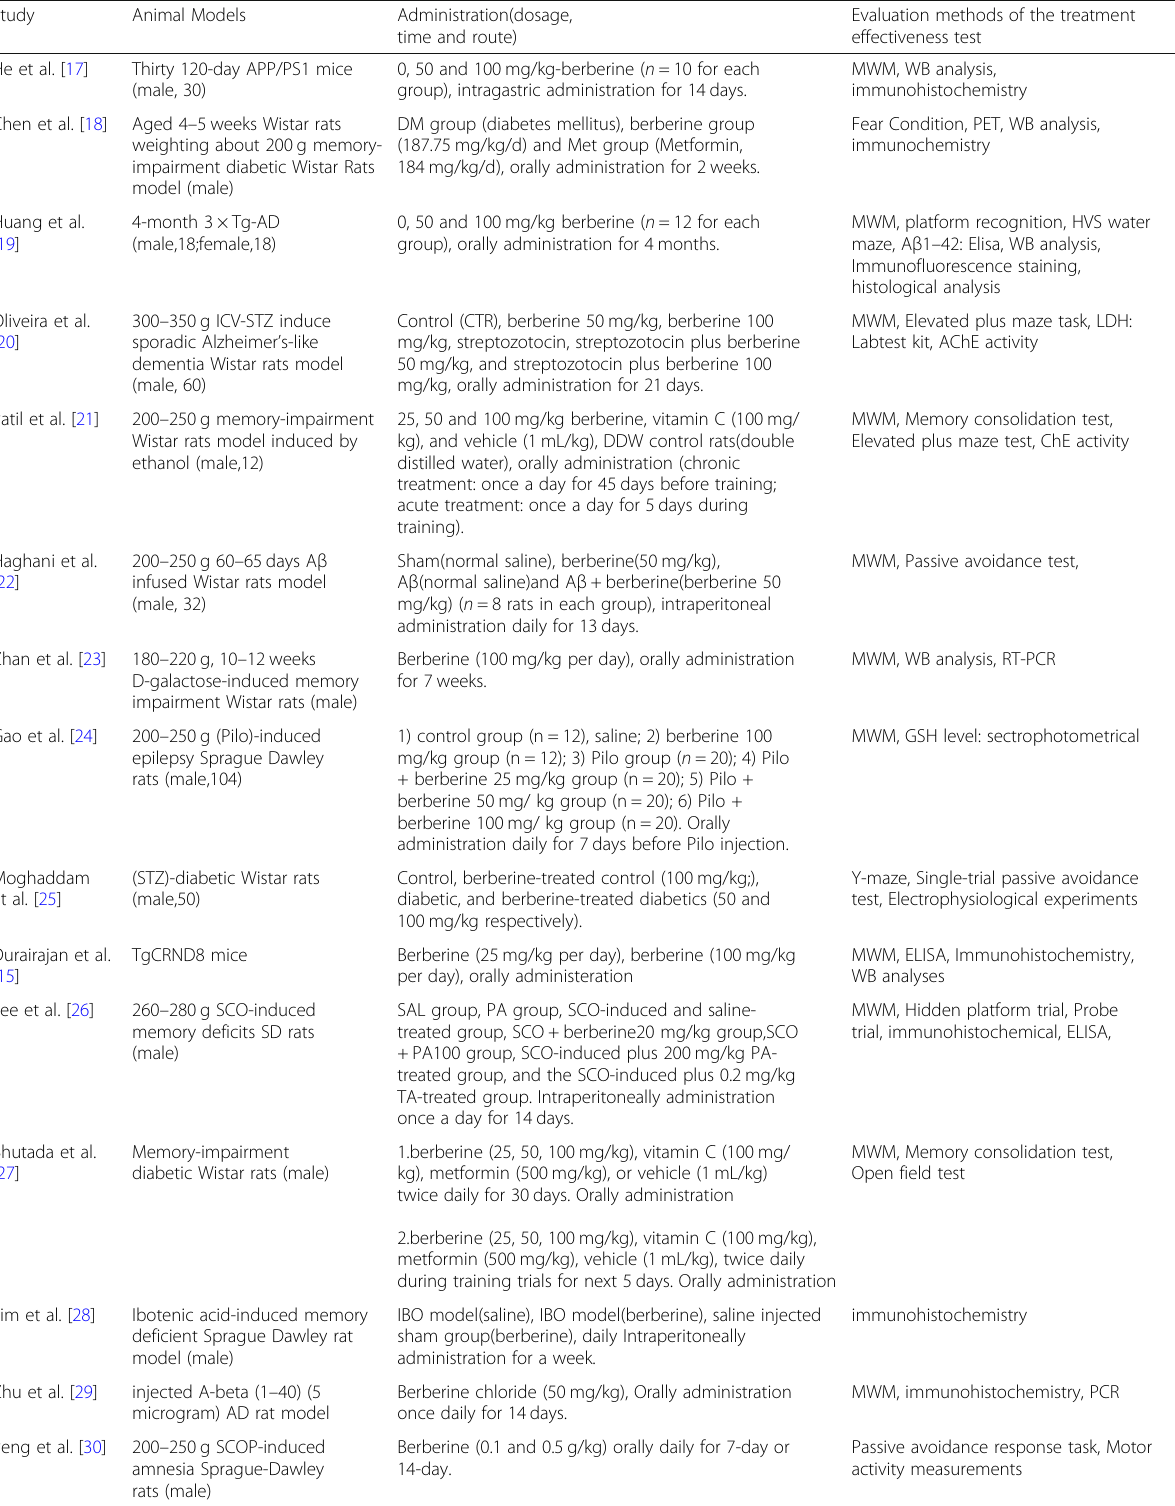
Table 1 Basic information of included